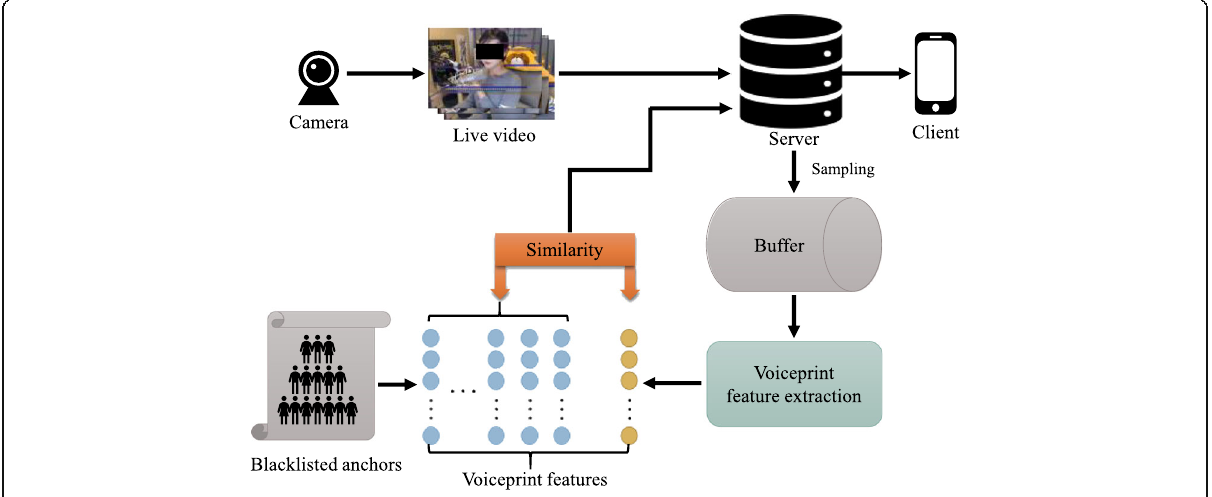
Fig. 1 The architecture of a live streaming system working with an anchor voiceprint recognition